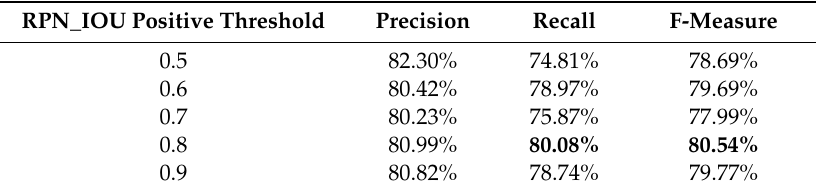
Table 3. The result with the different region proposal network Intersection over Union (RPN_IOU) positive thresholds.